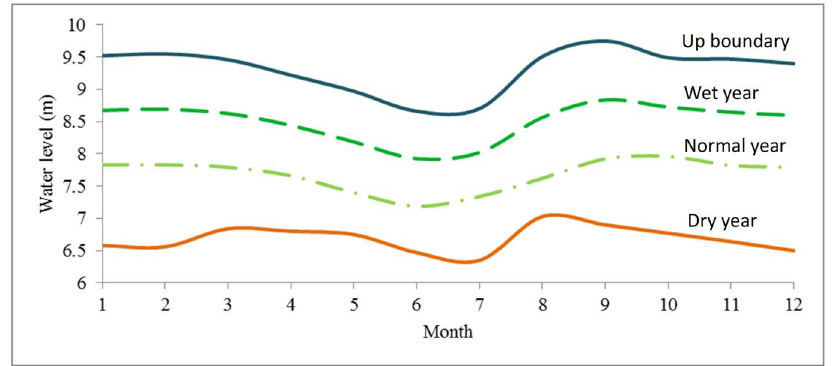
Figure 10. Environmental flow recommendations. Environmental flow recommendations include four components for different years: dry year, normal year, wet year and up boundary. The water level in every month should be maintained above different